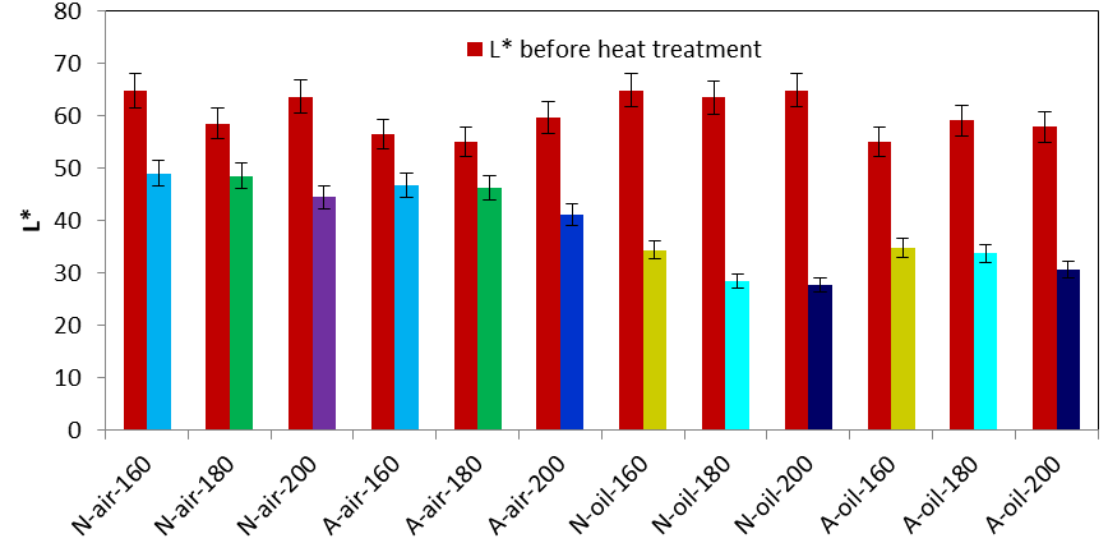
Figure 1. The influence of heat treatment under air or palm oil on Afrormosia and Newtonia on the L ∗ parameter.